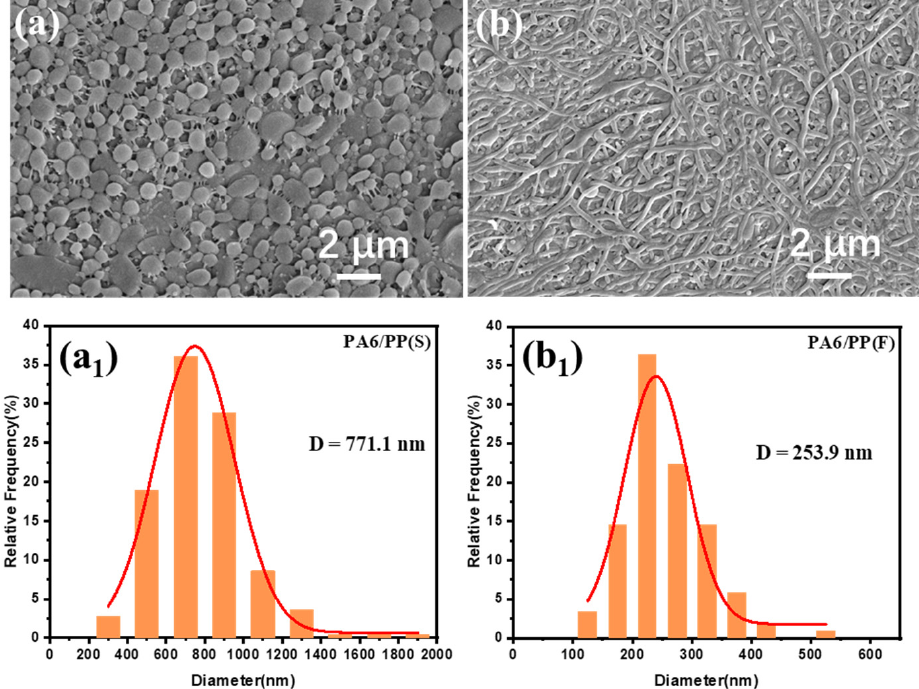
Figure 2. SEM images of ( a ) PA6/PP(S) and ( b ) PA6/PP(F) films after high-temperature treatment with decalin to remove the PP phase. The diameter distribution curves and average diameter (D) of PA6 spherical particles and fibers are shown in ( a1 , b1 ).